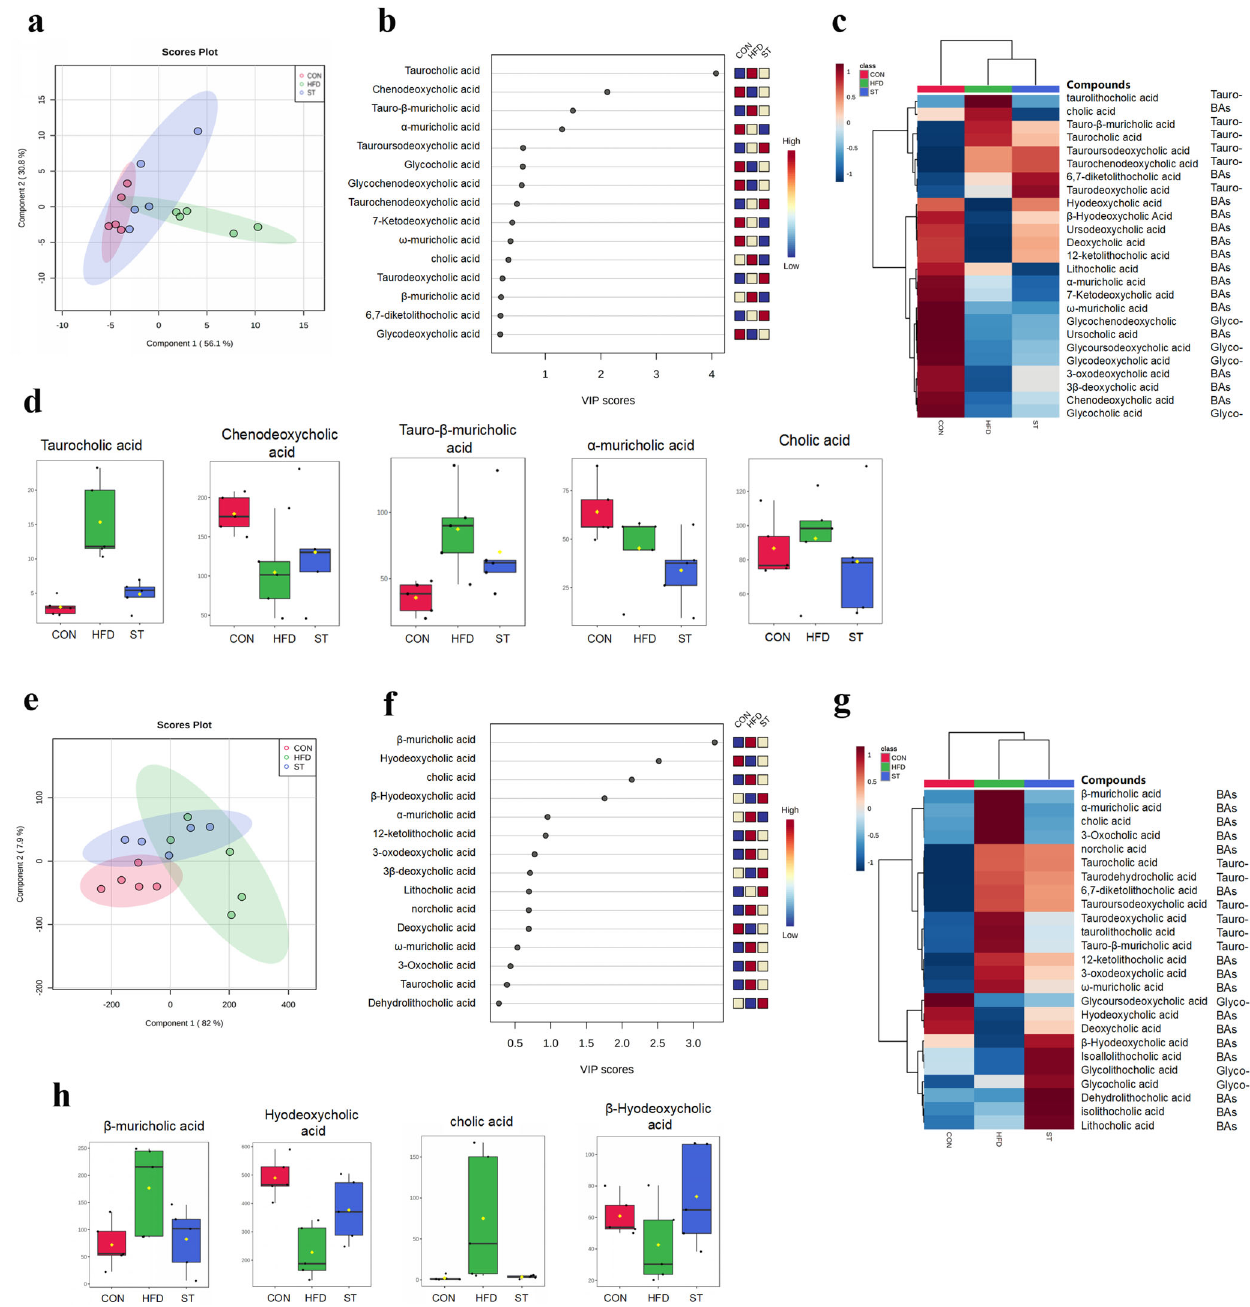
Fig. 3 ST altered serum and fecal BA pro fi les in HFD fed rats. a PLS-DA scores plots in serum among the groups; b variable importance in projection (VIP) scores were identi fi ed by PLS-DA; c hierarchical clustering heatmaps of the top 25 BAs contents in serum among the groups; d the levels of biomarker BAs in serum among groups; e PLS-DA scores plots in feces among the groups; f VIP scores were identi fi ed by PLS- DA; g hierarchical clustering heatmaps of the top 25 BAs contents in feces among the groups; h the levels of biomarker BAs in feces among